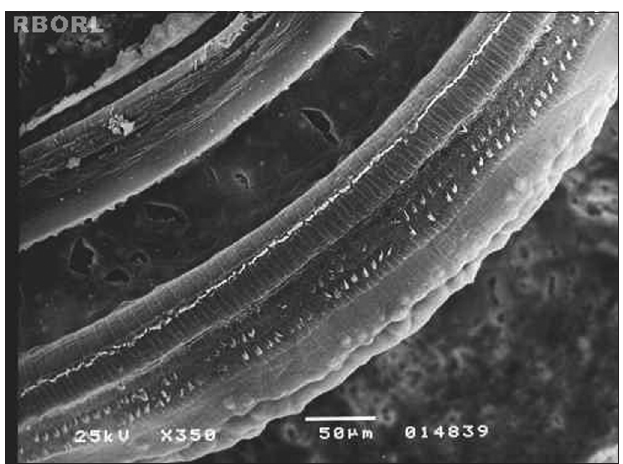
Figura 4. Fotomicrografia de órgão de Corti normal encontrado em cobaia do grupo 4, exibindo E3 panoramicamente. Observe ausência de CCE em F1, F2 e F3. Ampliação 350x.